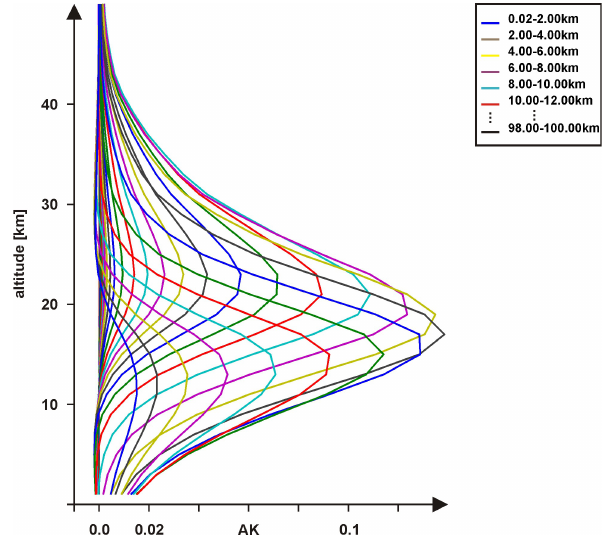
Fig. A1. Representative averaging kernels of the FTIR HCN re- trieval. The colored lines indicate the sensitivity and resolution of each individual